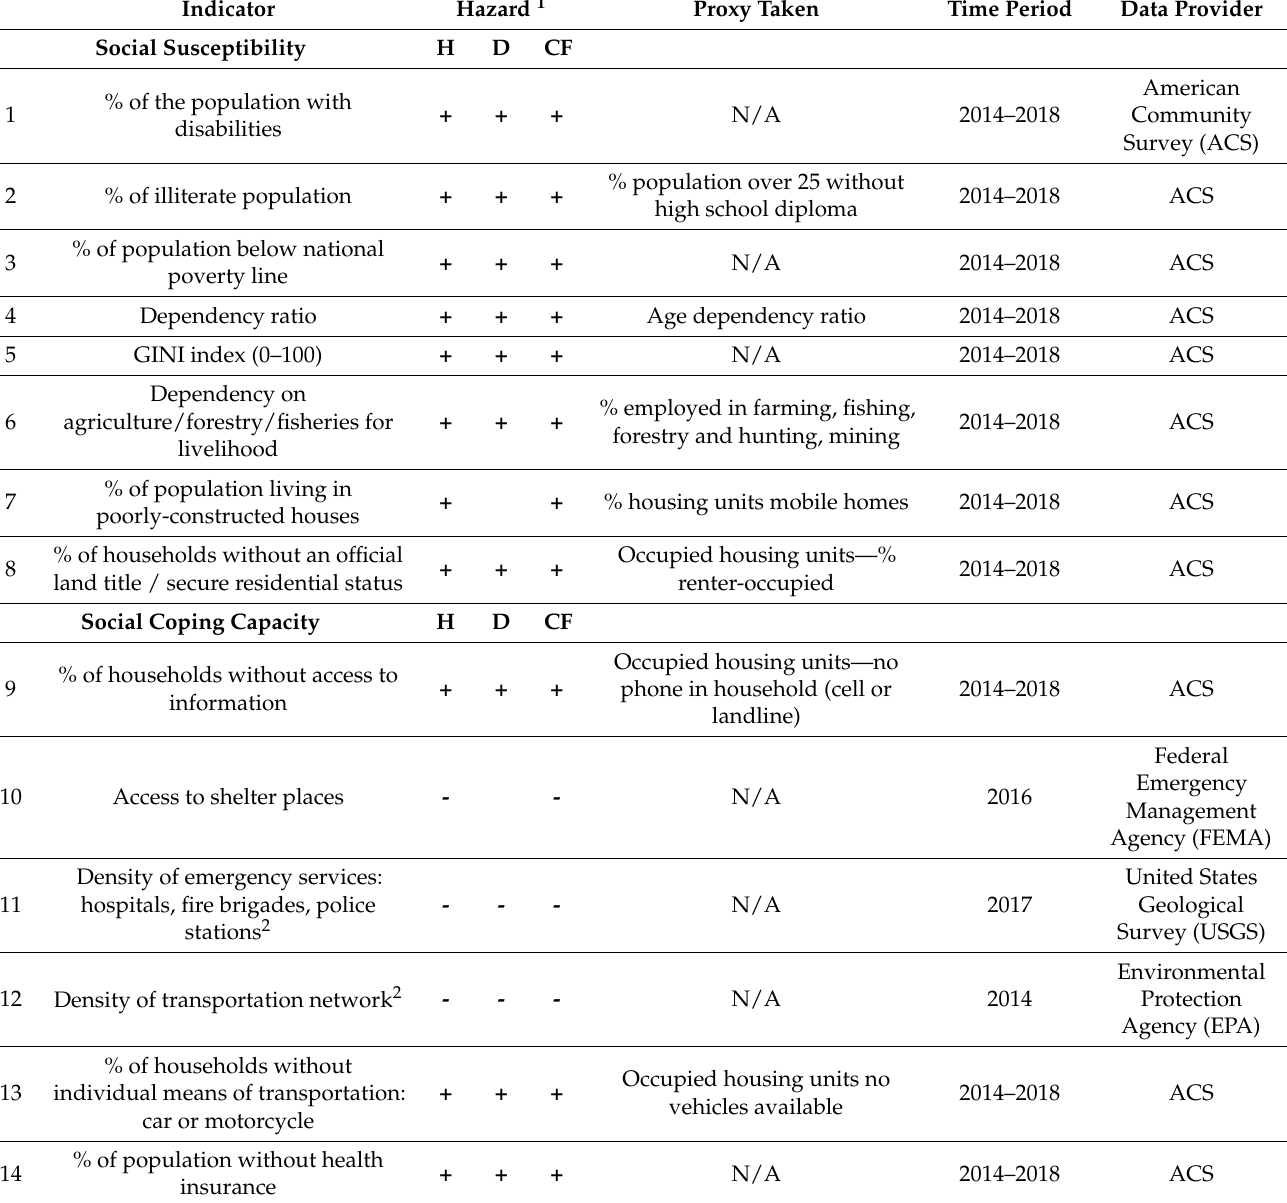
Table 1. Vulnerability component indicators used in the assessment arranged by subcomponent (social susceptibility, social coping capacity, ecosystem susceptibility, and ecosystem robustness). For hazard-specific scores, the indicators’ relevance and cardinality ((+) for increasing vulnerability and (-) for decreasing vulnerability) for each hazard type was determined in a literature review by Sebesvari et al. (2016) [12]. Hazard types include hurricane force wind (H), drought (D), and coastal flood (CF). Proxies were used when their indicator data were more relevant to the Mississippi Delta context or otherwise not